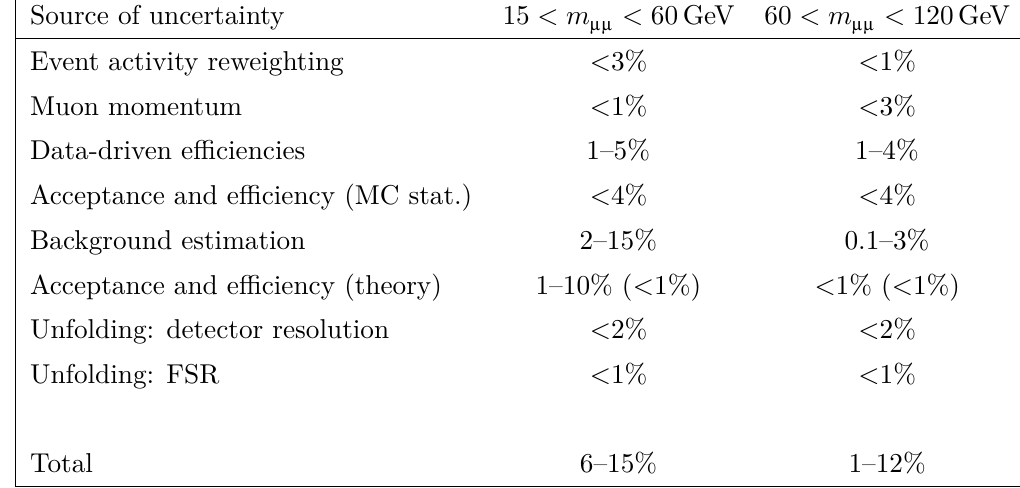
Table 1 . Range of systematic uncertainties in percentage of the cross section, given separately for 15 < m < 60 and 60 < m < 120 GeV. Systematic uncertainties for the three mass bins mm mm above 120 GeV fall in the range given for 15 < m < 60 GeV. For the theoretical component of mm acceptance and efficiency, the systematic uncertainty related to efficiency alone (for fiducial cross sections) is given between